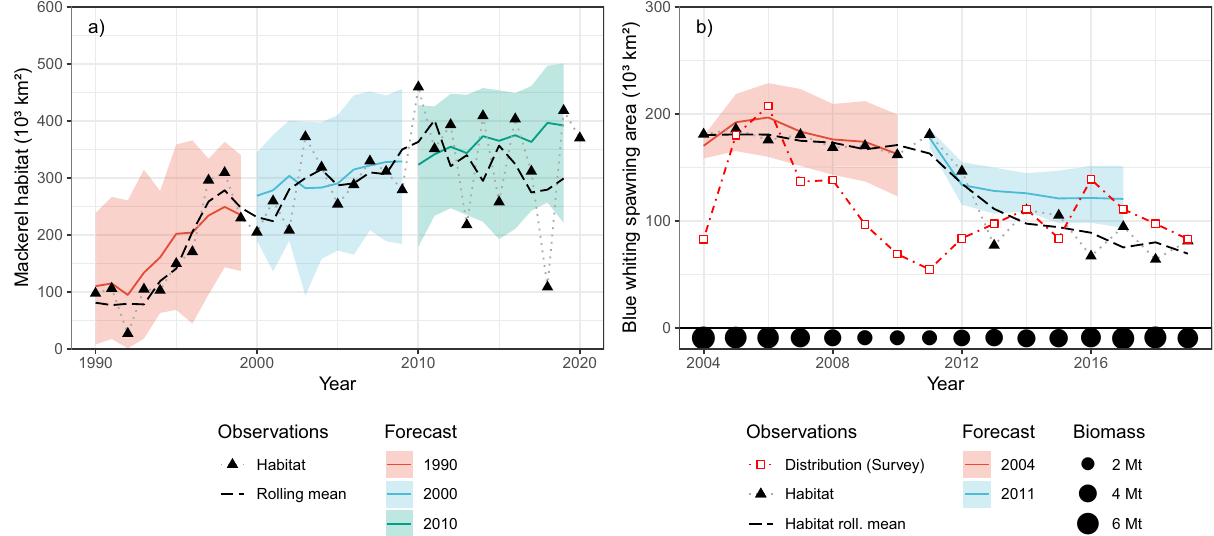
Fig. 4 Key habitat and distribution shift events can be forecast. Habitat forecasts from the best performing individual model system (CESM-DPLE) started at select times (solid coloured lines) are shown with the corresponding 90% range of realizations in this model (shaded colours area) for the area of ( a ) mackerel habitat around south Greenland and ( b ) blue whiting spawning habitat. Habitat metrics based on observed conditions (see Methods) in a given year are shown (triangles connected by dotted grey line) together with a three-year centred running mean (dashed black line) of these values. For ( b ), blue whiting, the distributional area estimated from scienti fi c monitoring surveys (red dashed line) is shown together with the stock biomass (bullets at bottom of fi gure) estimated by the stock assessment. An illustrative subset of predictions is shown on both panels: the full set for a 5 year lead-time can be seen in Fig. 3d – f. Source data are provided as a Source Data fi